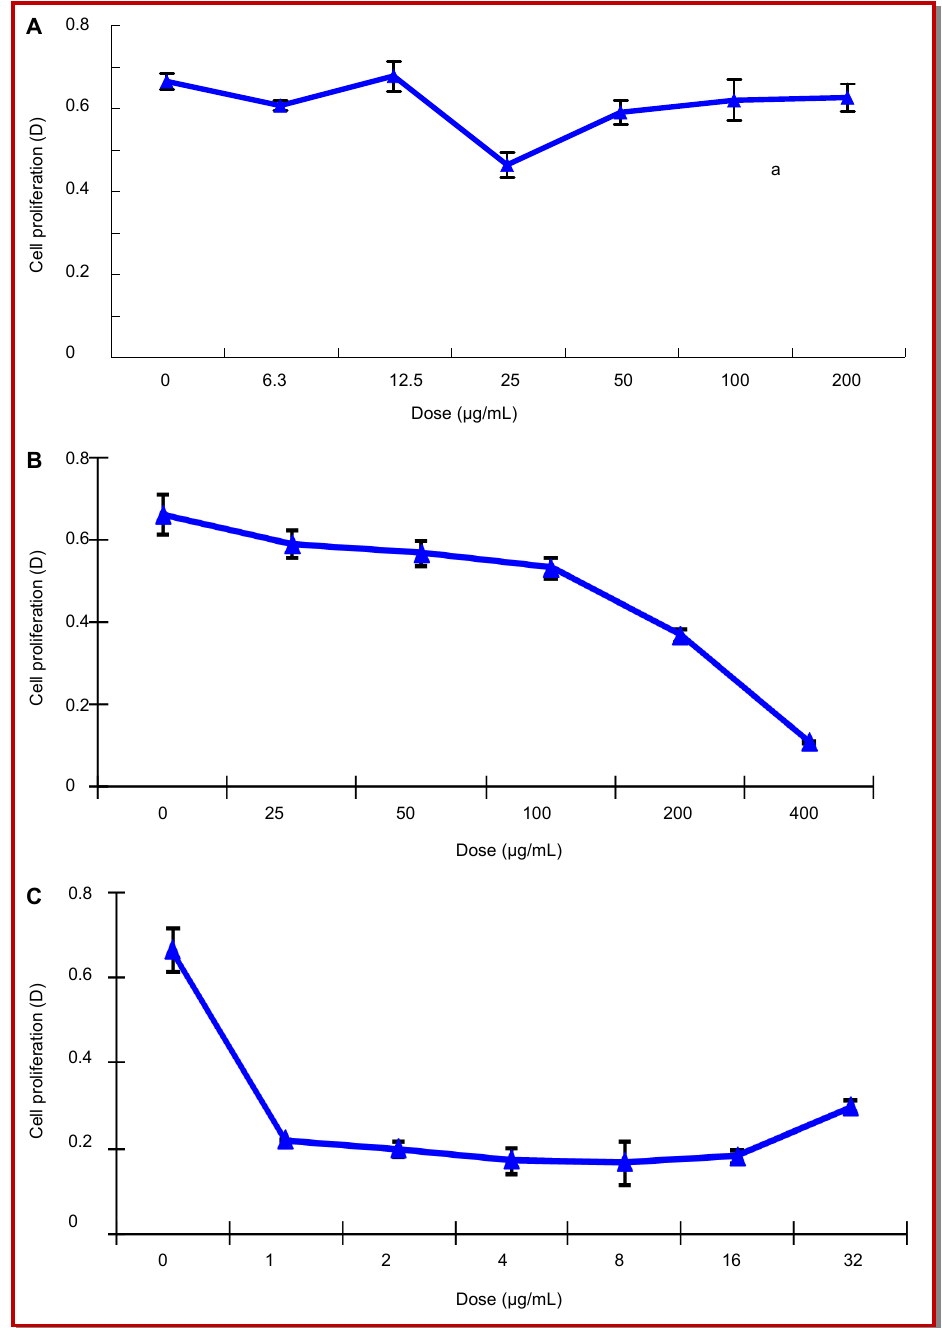
Figure 1: Influence of ICA (A), BAI (B), ADM (C) on HepG2 cells proliferation a p<0.01 vs control , n =